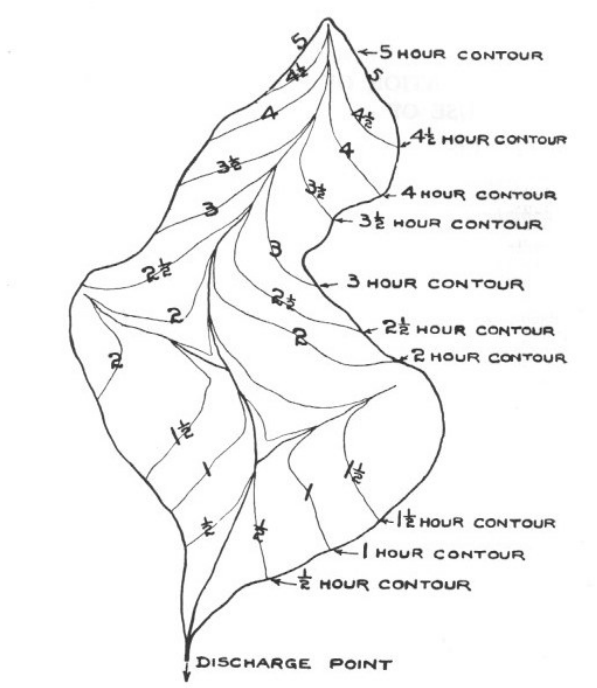
Figure 1. Schematic time delay contours or isochrones of travel time in a catchment based on velocities (after Ross, 1921, p. 86). He states that “A time contour line may be defined as a line drawn on the plan from all points on which water would take the same time to flow to the discharge point for the area.” (Ross, 1921, p.